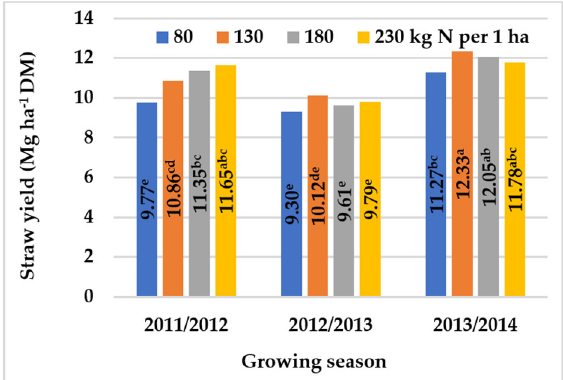
Figure 7. The effect of N rate on the straw yield of winter oilseed rape, across growing seasons (2011– 2014). Means with the same letters do not differ significantly at p ≤ 0.05 in Tukey`s test.